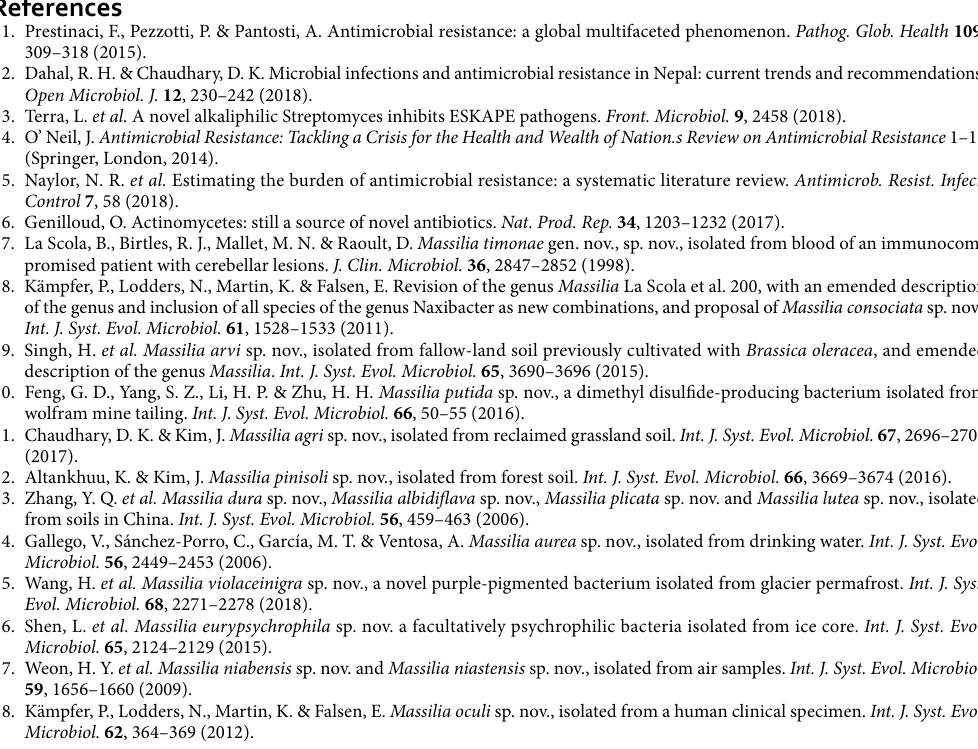
rRNA gene sequence and the whole genome sequence of strain TW-1 T are MN661193 and JAAQOM000000000, respectively.